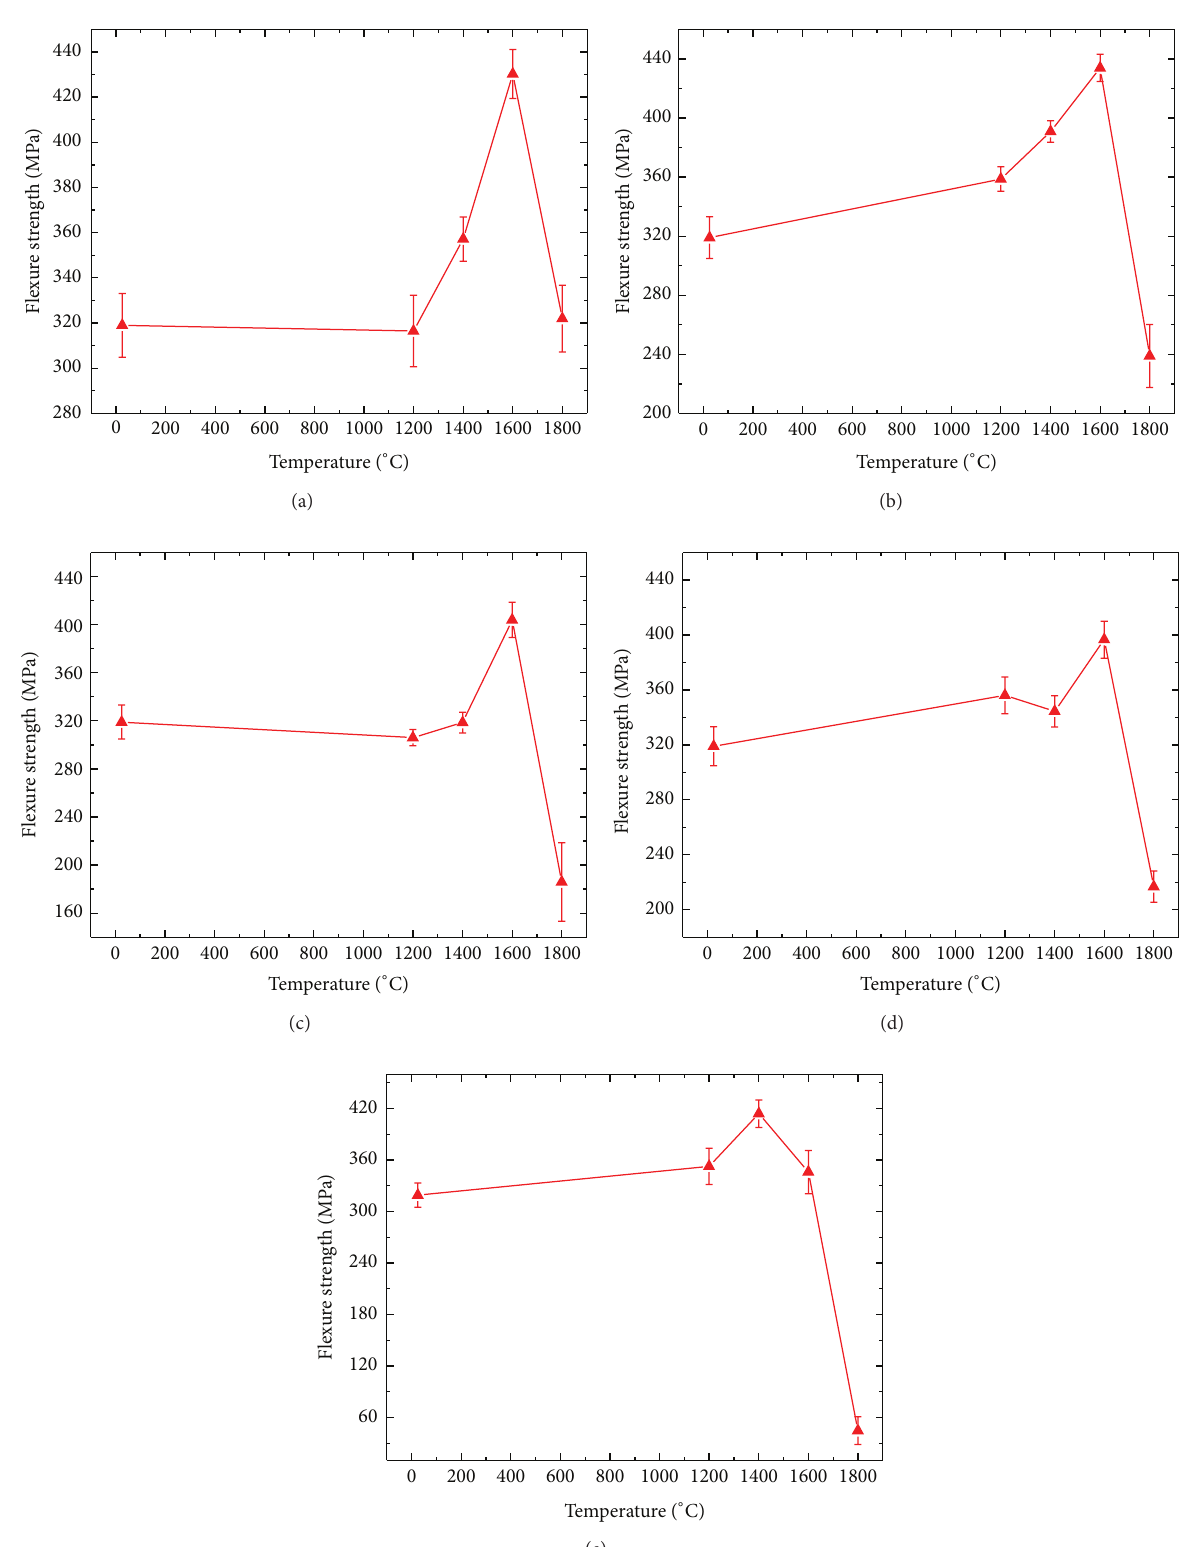
Figure 9: Residual strengths of ZSB materials at different thermal shock temperature: (a) 10 times; (b) 20 times; (c) 30 times; (d) 40 times; (e) 50